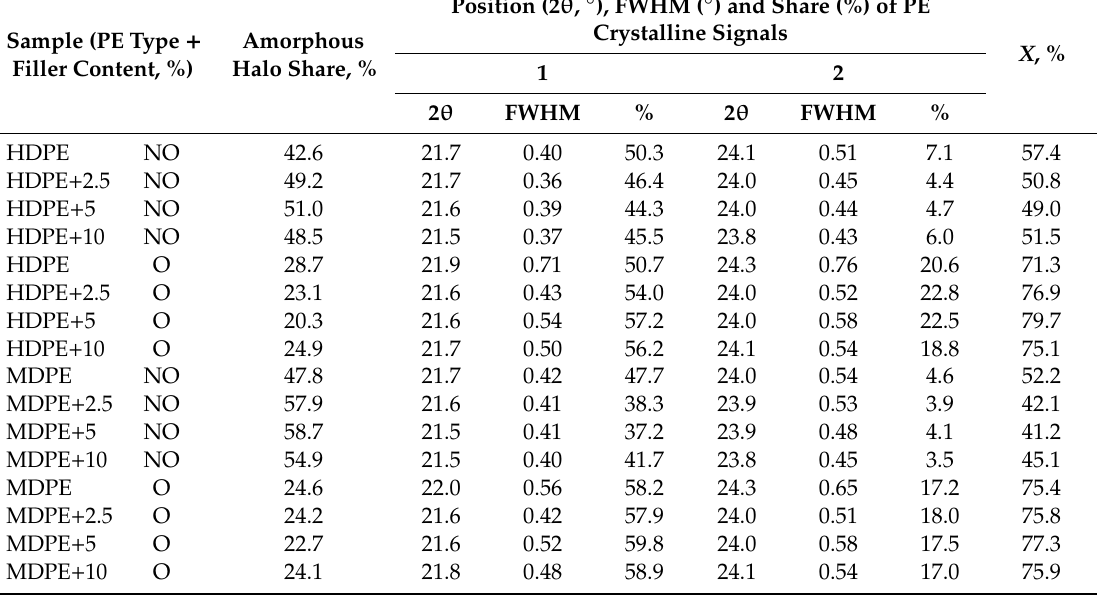
Table 1. Results of XRD analysis for non-oriented (NO) and oriented (O) HDPE, MDPE and their composites with Sillikolloid filler (FWHM, full width at half maximum of peak; X , crystallinity degree of